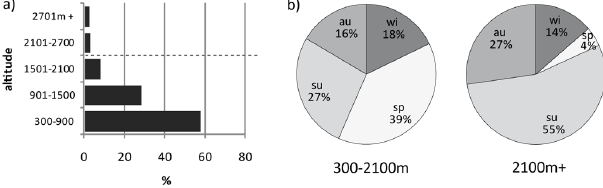
Fig. 2. (a) Rockfall distribution with elevation; (b) seasonal dis- tribution in the two rough elevation ranges “probably below per- mafrost line” (300–2100m) and “possibly permafrost-influenced”